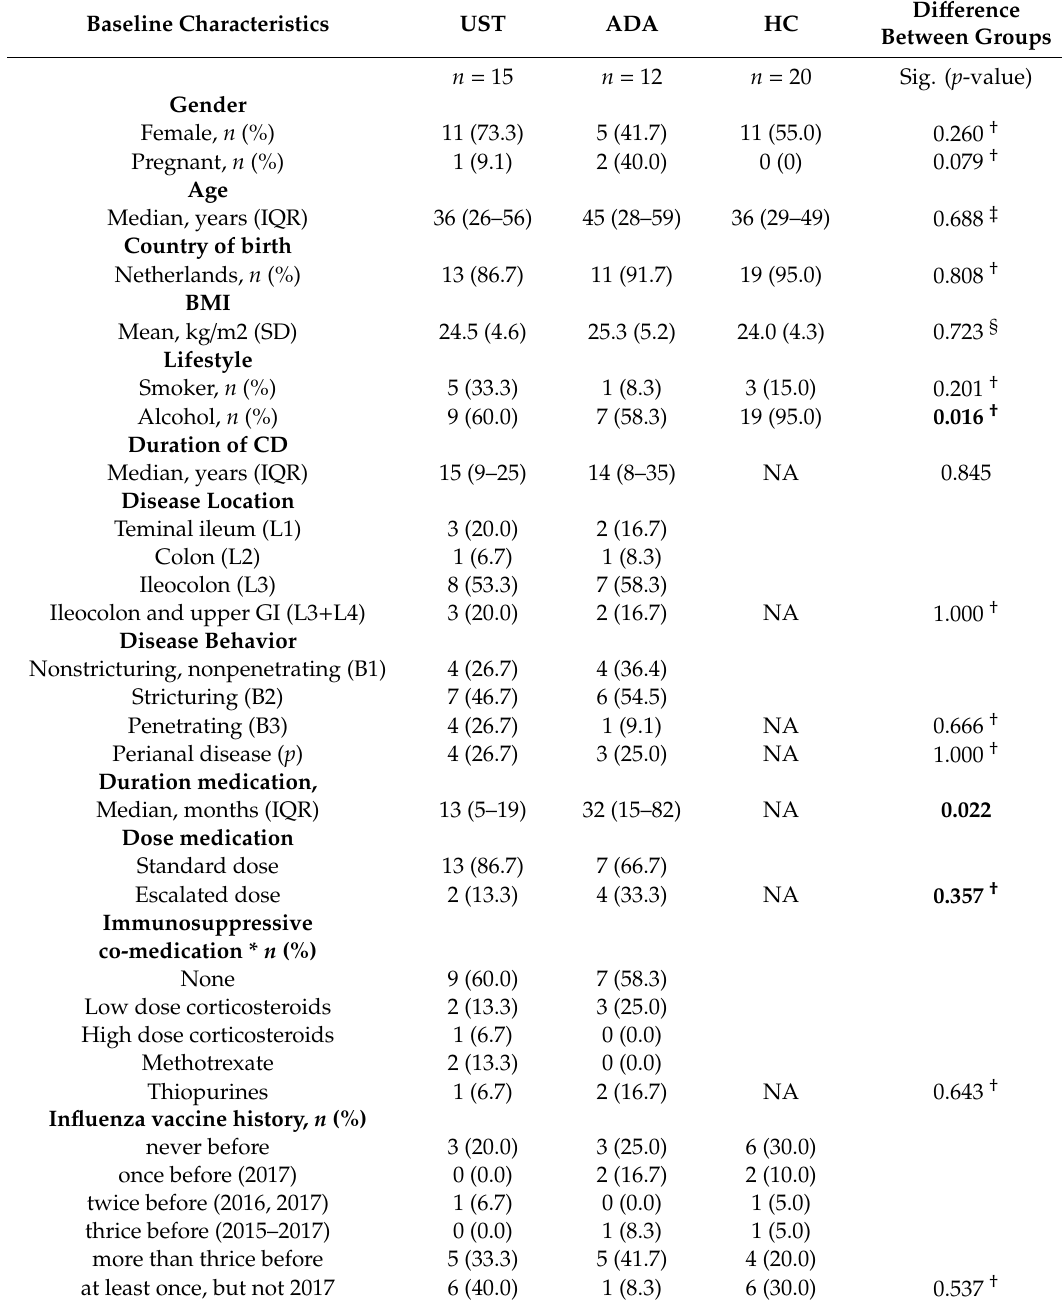
Table 1. Baseline